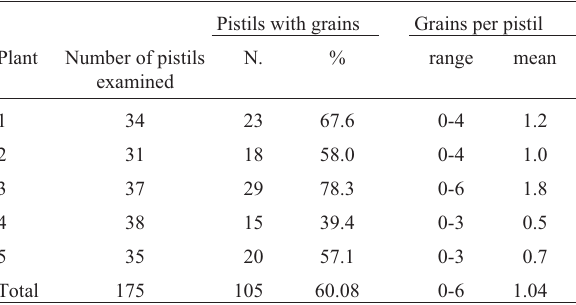
Table3 -Occurrenceofpollengrainson Eupatoriumlaevigatum stigmas. Pistils with grains Grains per pistil